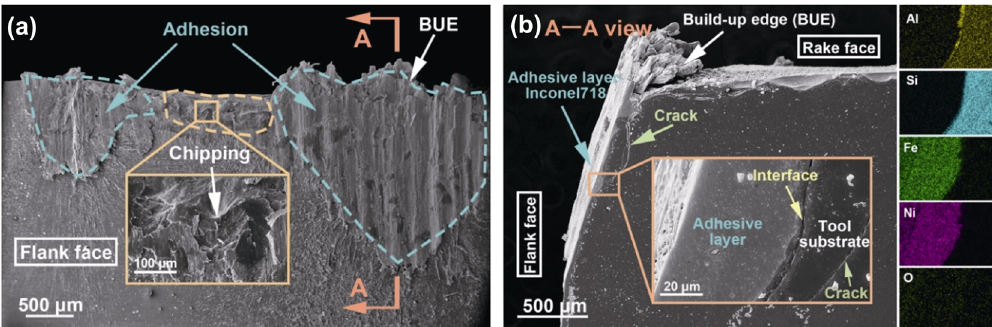
Fig. 14 SEM images of worn morphologies of sample Y2 (RMV = 51.98 cm 3 ): (a) flank face, (b) cross-sectional morphology (A–A view), and corresponding EDX mapping of selected area.